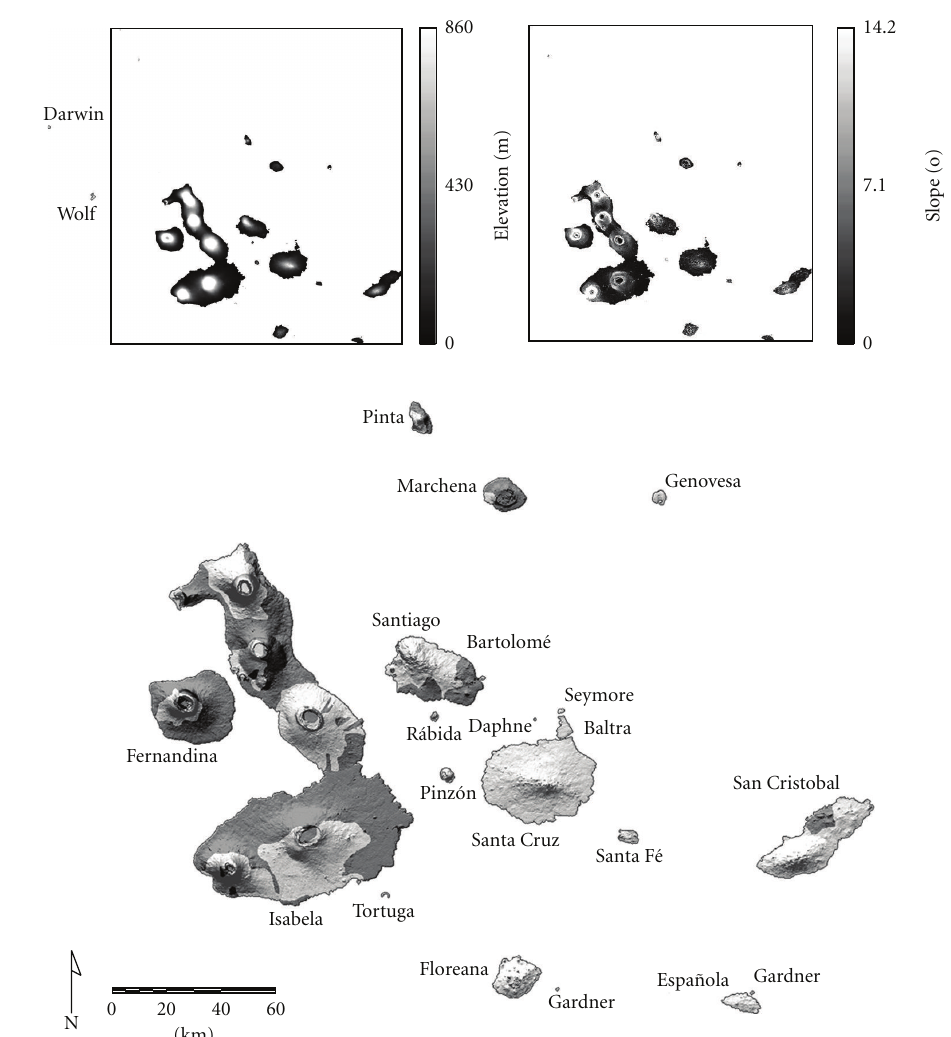
Figure 1: The islands of the Gal´apagos Archipelago used in analyses ( n = 22). Topography is in shades of grey, with lava flows in darker shades. Insets show elevation and slope, with upper ranges defined by the mean plus twice the standard